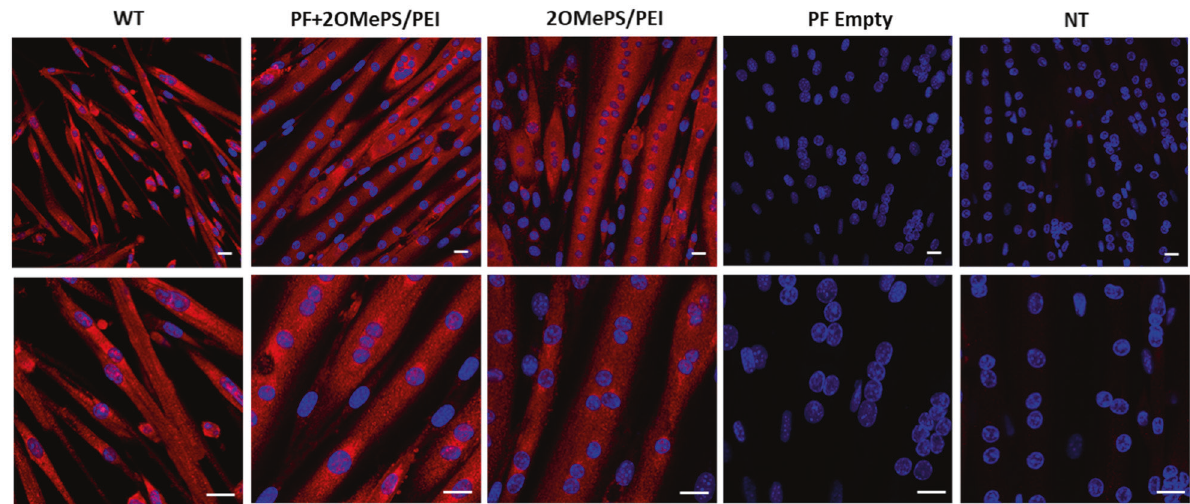
Fig. 2 In Vitro dystrophin restoration using AON-laden PF microspheres. Dystrophin immunostaining (red) and DAPI staining (blue) of mdx myotubes after 72 h incubation with PF microspheres loaded with 2 µg of 2OMePS/PEI AON polyplexes. Control groups of free 2OMePS/PEI AON polyplexes were stained and compared to negative controls of non-treated mdx myotubes and mdx myotubes treated with empty PF microspheres. Wild type C-57 mouse myotubes were stained as a positive control, ( n = 3). Scale bar = 20